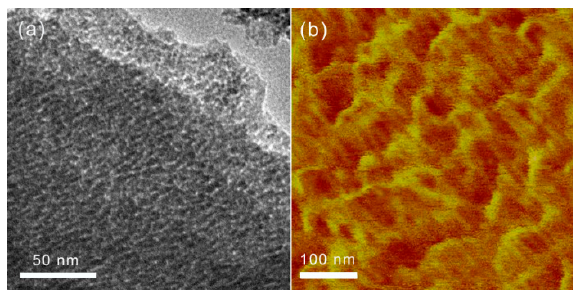
Figure 3. Microphase separated morphology images regarding ( a ) atomic force microscopy (AFM) and ( b ) transmission electron microscopy (TEM) of membrane C-HBM-1.78.